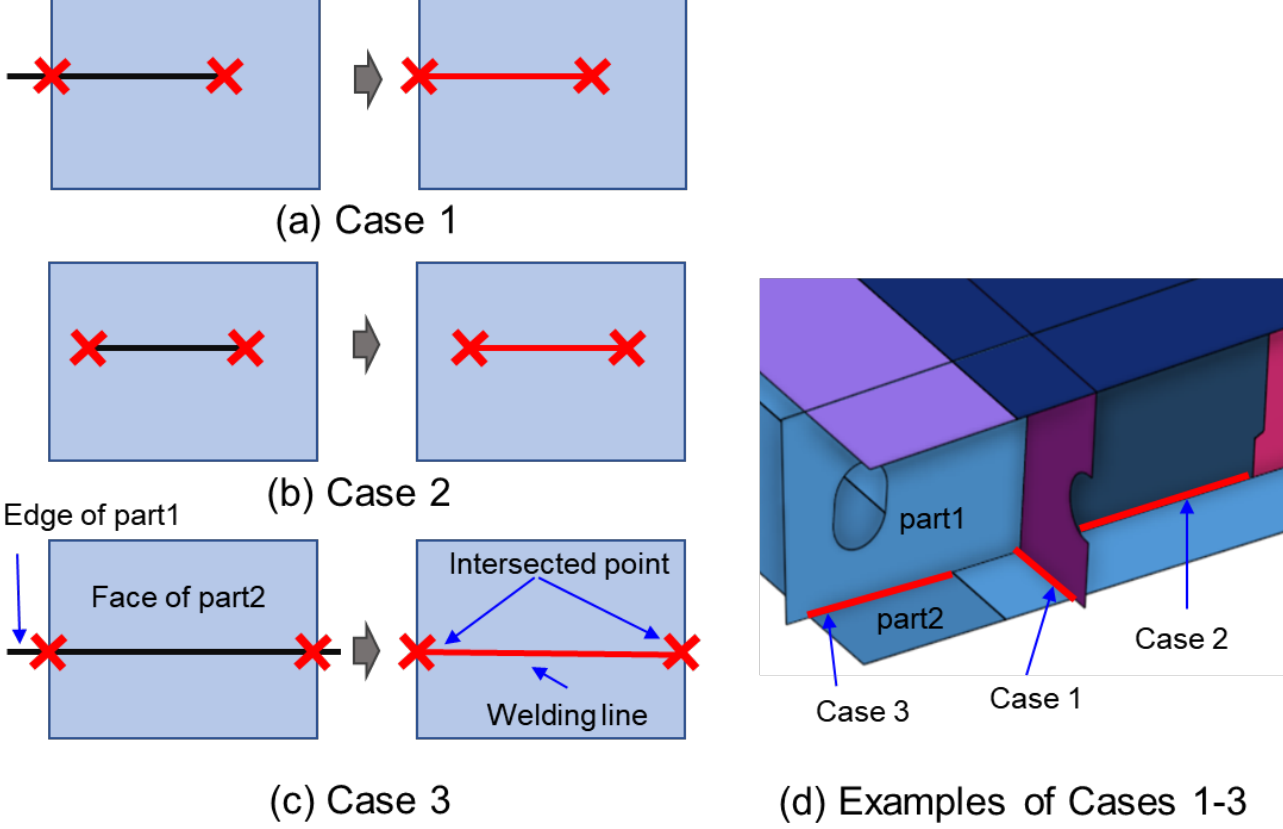
Figure 7. Weld line generation according to part joint conditions.